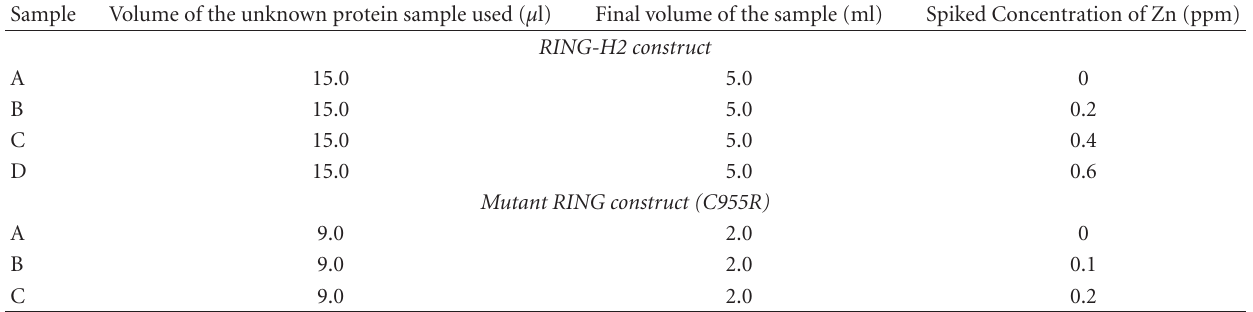
Table 1: Samples of each construct spiked with Zn prepared and analyzed.